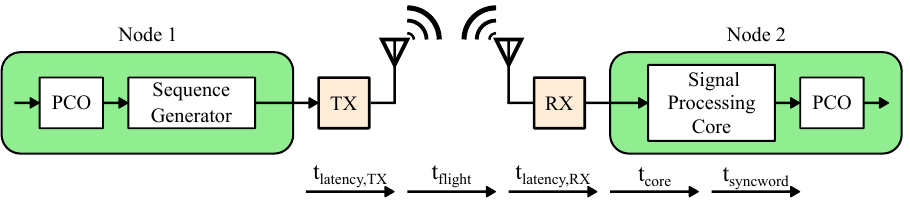
Figure 12. Visual illustration of Equation (1). The latencies are due to the following: receive and transmit digital filter delays, speed of light propagation delay, and the syncword duration.